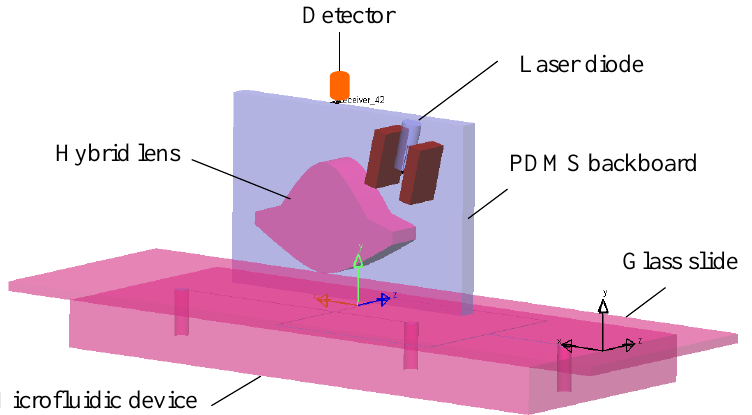
Figure 2. Schematics of: ( a ) Laser focusing lens; ( b ) Hybrid lens combining fluorescence collecting lens (B + A ) and laser focusing lens (A 1 2 functions of laser focusing and fluorescence